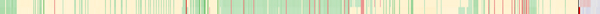
Row-aggregated eQTL data. All 696 significant SNPs are shown. Patients were aggregated into two groups according to their affection states.